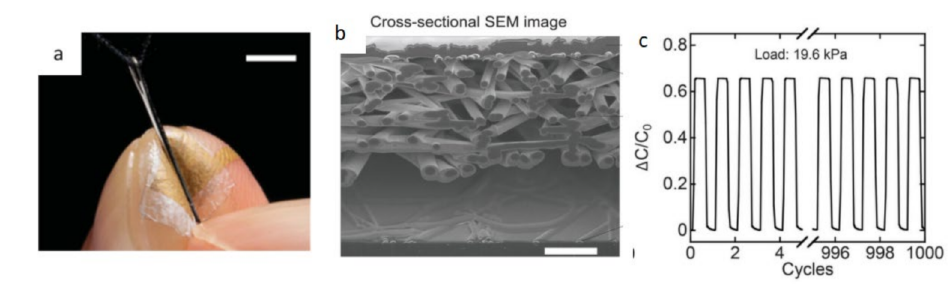
Figure 9. Schematic diagram of a pressure sensor without sensory interference. ( a ) Pressure sensor placed on index finger; ( b ) SEM image of the cross-section of the nanomesh sensor; ( c ) pressure sensitivity at 1000 cycles of pressure